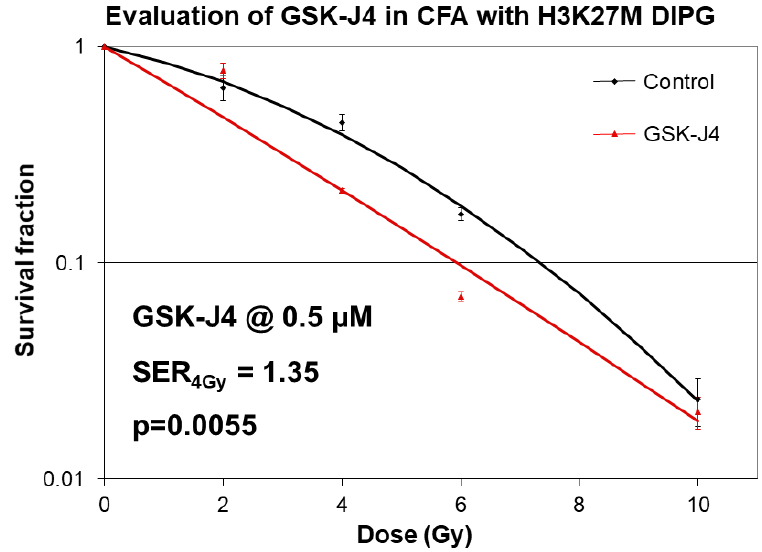
Figure 4. Radio-sensitizing effects of GSK-J4 in clonogenic survival assays in H3K27M DIPG cells. Clonogenic survival assays with SF8628 pediatric DIPG cell line harboring the histone H3.3 K27M mutation. DIPG cells were treated with 0.5 µM concentration of GSK-J4 both before and after radiation treatments (0–10 Gy doses). Survival fractions were determined 2 weeks after plating. Curve fitting was performed using linear quadratic equation. Sensitizer enhancement rations (SERs) were calculated for the dose 4 Gy. Mean SERs from two independent experiments with 3 data points per experiment are shown followed by SER 4Gy = sensitizer enhancement ratio at 4 Gy radiation dose. GSK-J4.